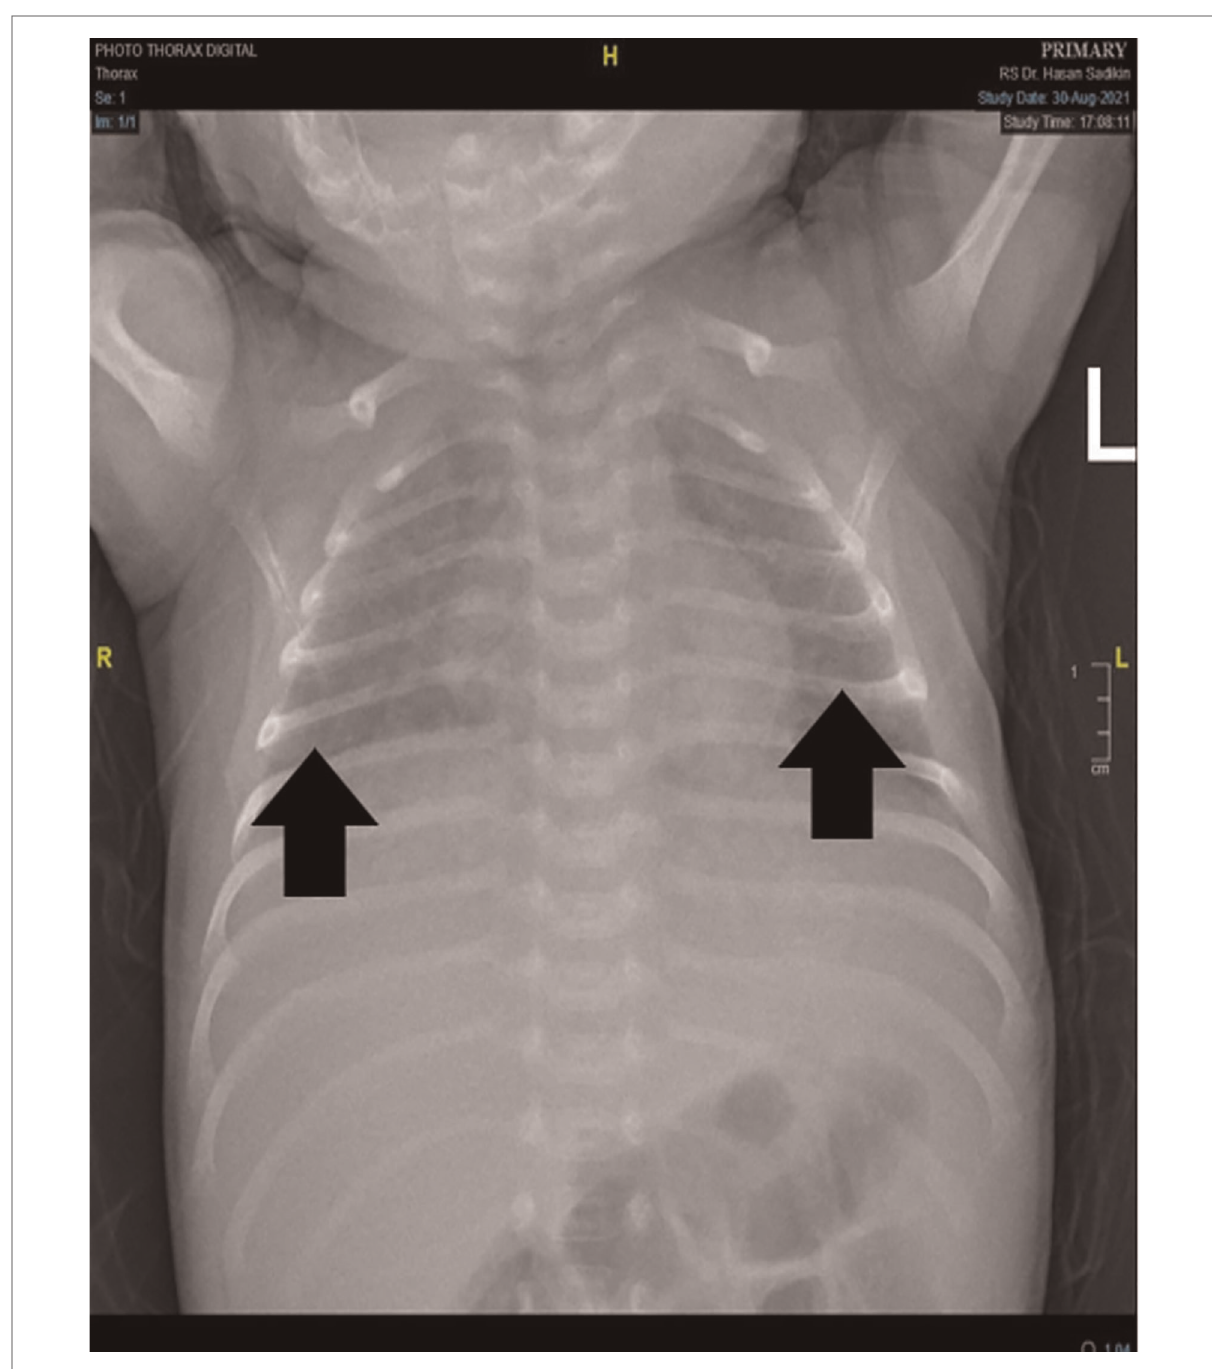
FIGURE 1 Chest x-Ray. showed inhomogeneous opaque coverings within upper and lower lung fi elds bilaterally (black